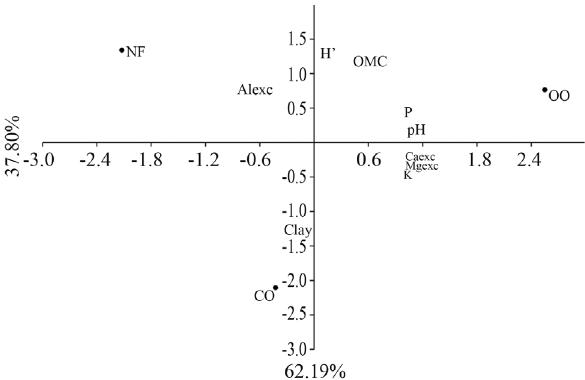
Figure 2 - Principal component analysis (PCA) of the diversity indexes ( H ’) and soil properties [clay, organic matter content (OMC), pH, P, K, Mg exc , Ca exc , and Al exc ] of the three sampling sites. Principal component 1 and 2 accounted for 62.19% and 37.81% of the total variation, respec- tively. NF = Native Field; CO = Conventional Orchard; OO = Organic Or-